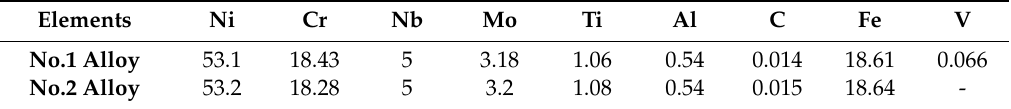
Table 2. Chemical composition of two alloys (weight percentage wt.%).